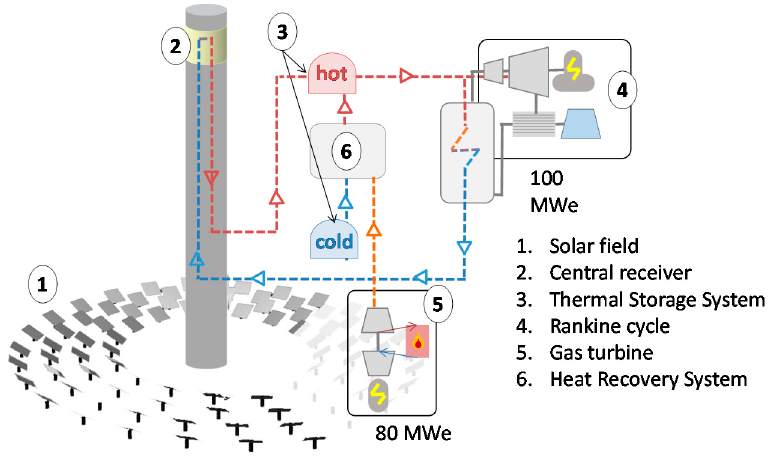
Figure 1. Configuration of the HYSOL concentrated solar power (CSP) plant.